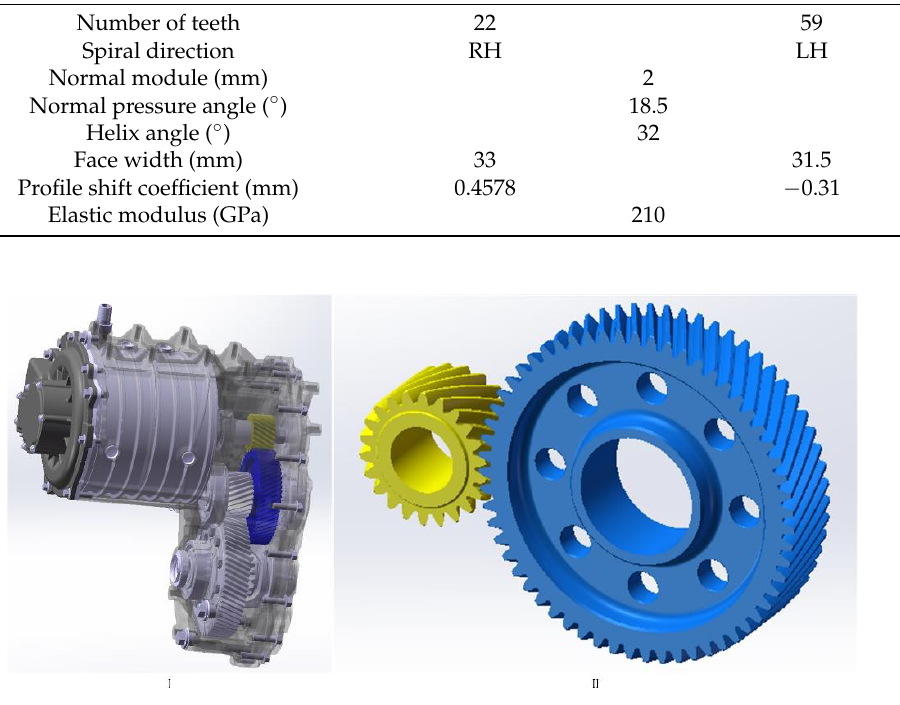
Figure 1. Three-dimensional model: ( I ) BEV gearbox; ( II ) Helical gear pair. A 12-DOF bending-torsion-axis-swing coupling dynamic model of helical gear trans- mission was established, as shown in Figure 2, where θ x , θ y are swings around the x - and y -axes, respectively; θ z is the torsional deformation around the z -axis; ϕ 1 is the angle between the meshing plane and the positive direction of the y -axis; β is the helical gear helix angle; T 1 , T 2 are driving and driven gear torque, respectively; O 1 , O 2 are geometric centers of driving and driven gears, respectively; k ix , k iy , k iz (i = 1,2) are the equivalent support stiffness of driving and driven gears in the x , y , and z directions, respectively; c ix , c iy , c iz (i = 1,2) are the equivalent support damping of driving and driven gears in the x , y , and z directions, respectively; k m , c m are time-varying meshing stiffness (TVMS) and meshing damping, respectively.